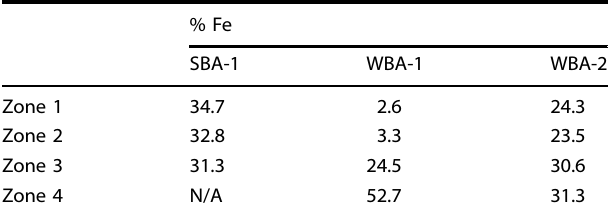
Table 1. EDS analysis of SBA-1, WBA-1, and WBA-2: % Fe for the four selected